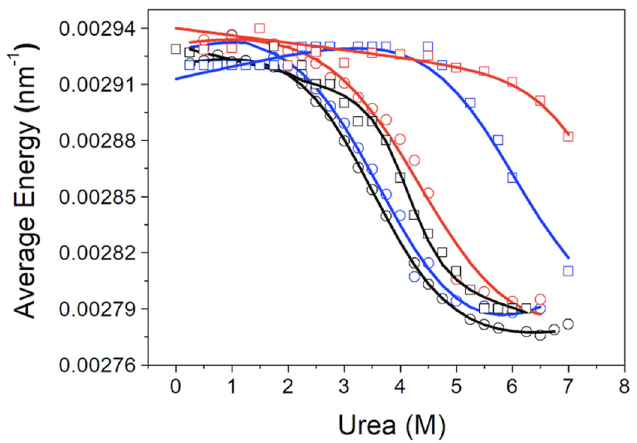
Figure 3. Chemical unfolding curves for MBD (circles) and NTD-MBD-ID (squares). The spectral average energy of the protein was represented as a function of the urea concentration: free protein (black), protein bound to unmethylated CpG-dsDNA (blue), and methylated mCpG-dsDNA (red).